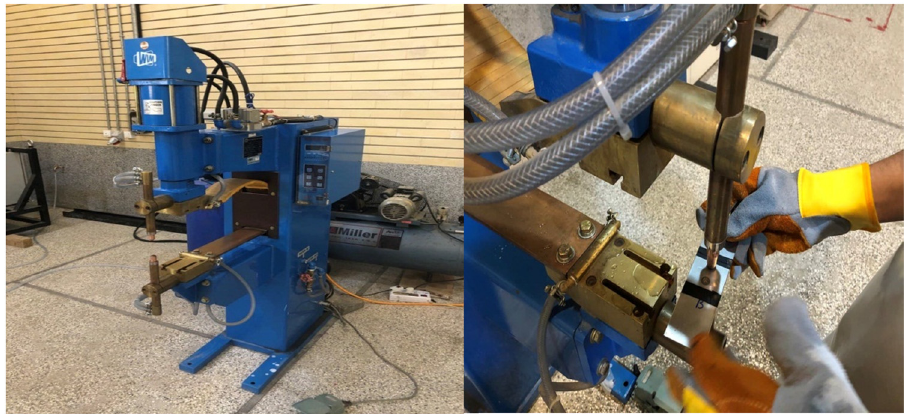
Figure 8: Spot welding machine.